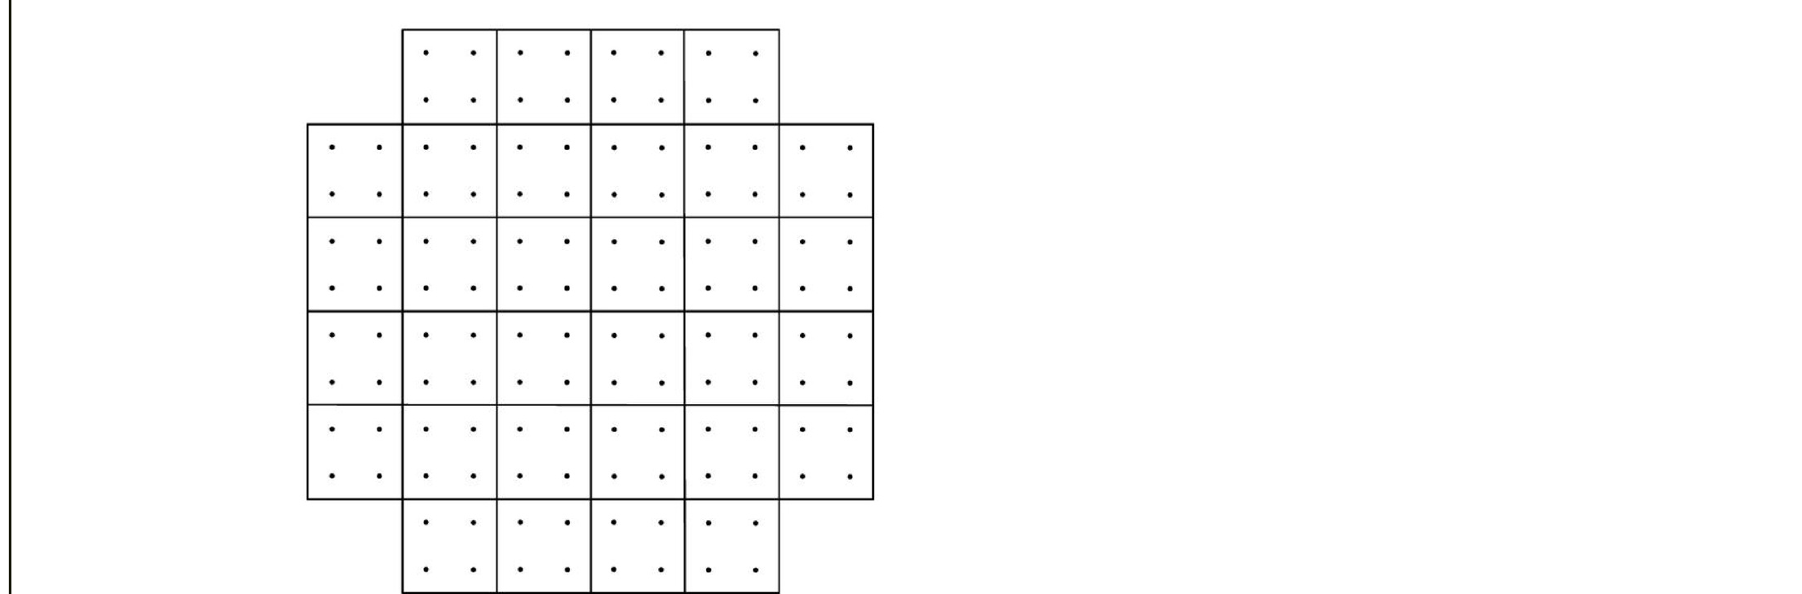
Figure 1 Block structure of XQAM. A square block array with the 4 corner blocks deleted, each block with ) is shown here as an